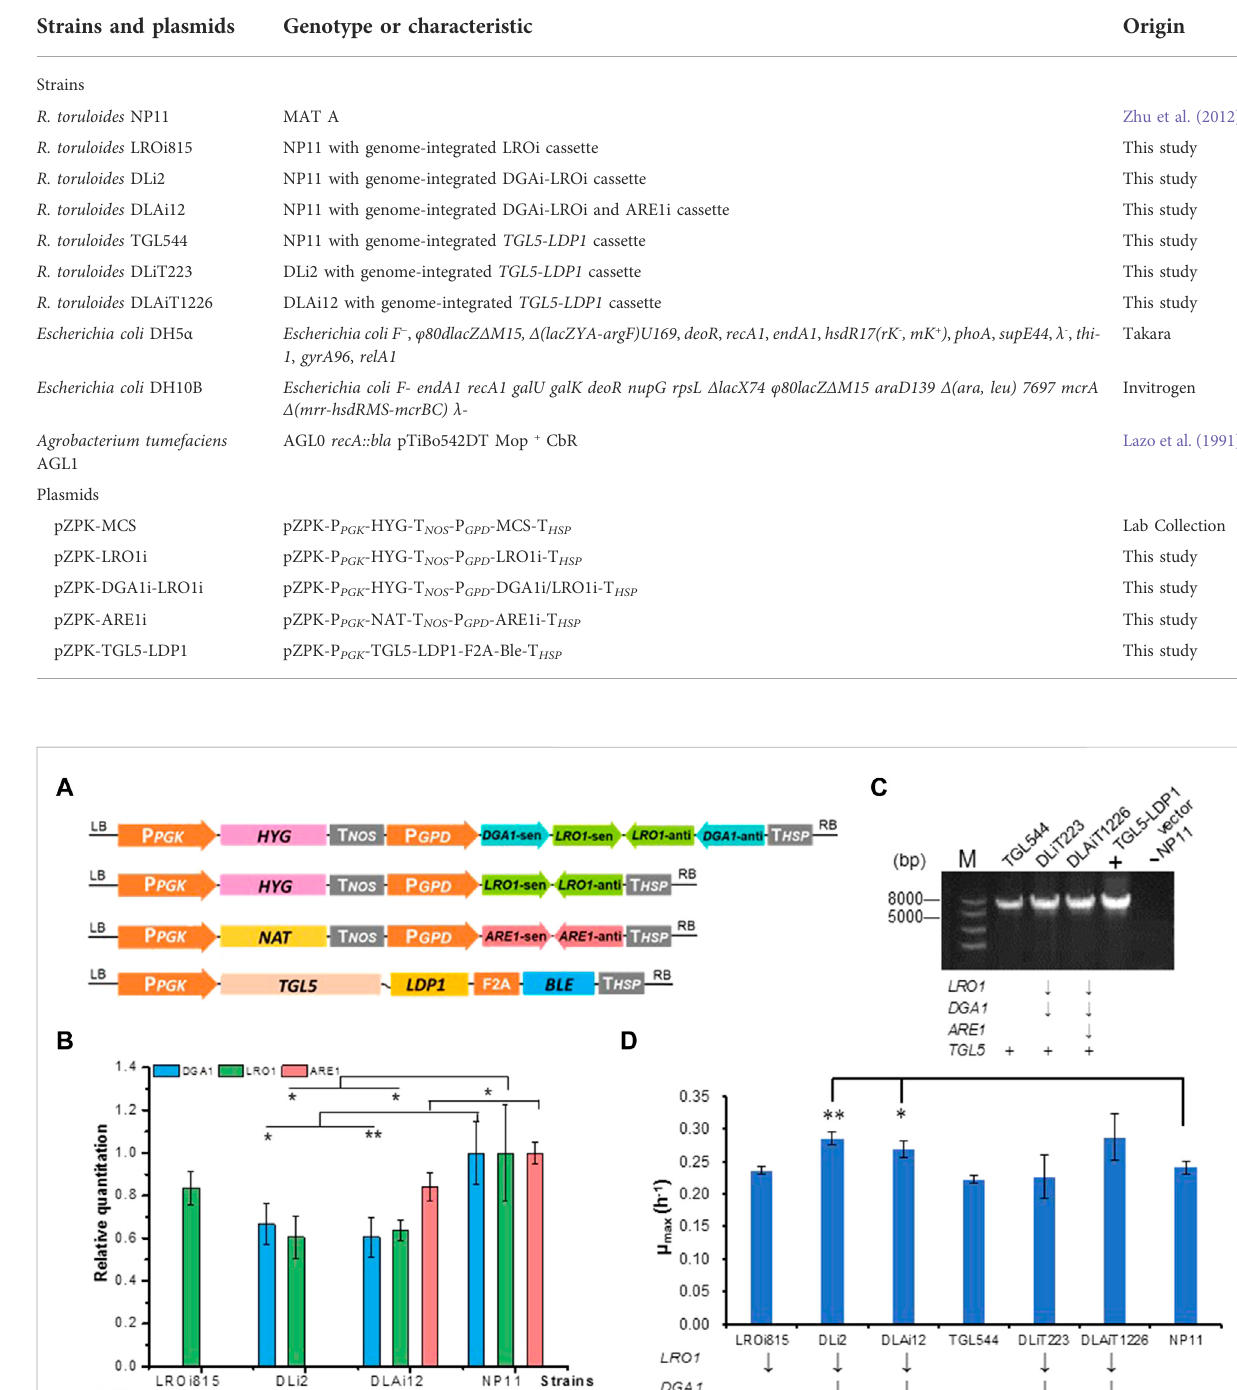
TABLE 1 Strains and plasmids were used in this study.